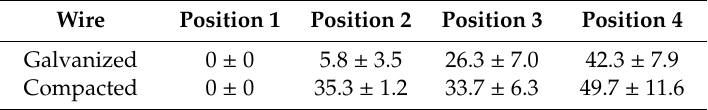
Figure 15. MBN versus different coating thickness: ( a ) galvanized, ( b ) compacted. Table 3. Thickness of the galvanized layer in micrometers on the surface.